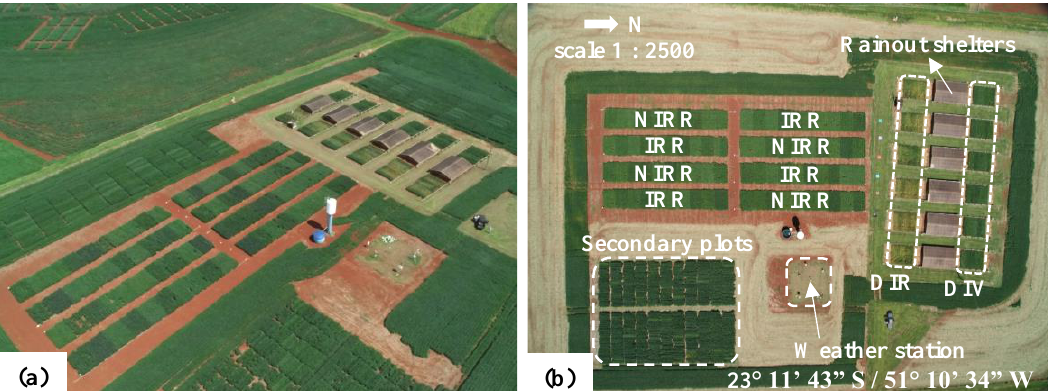
Figure 2. Experimental area overview ( a ) and description of the weather station and treatment plots ( b ): irrigated (IRR), non-irrigated (NIRR), and water deficits induced at vegetative (DIV) and reproductive (DIR) stages. RGB image obtained by an UAV carrying a regular digital camera.